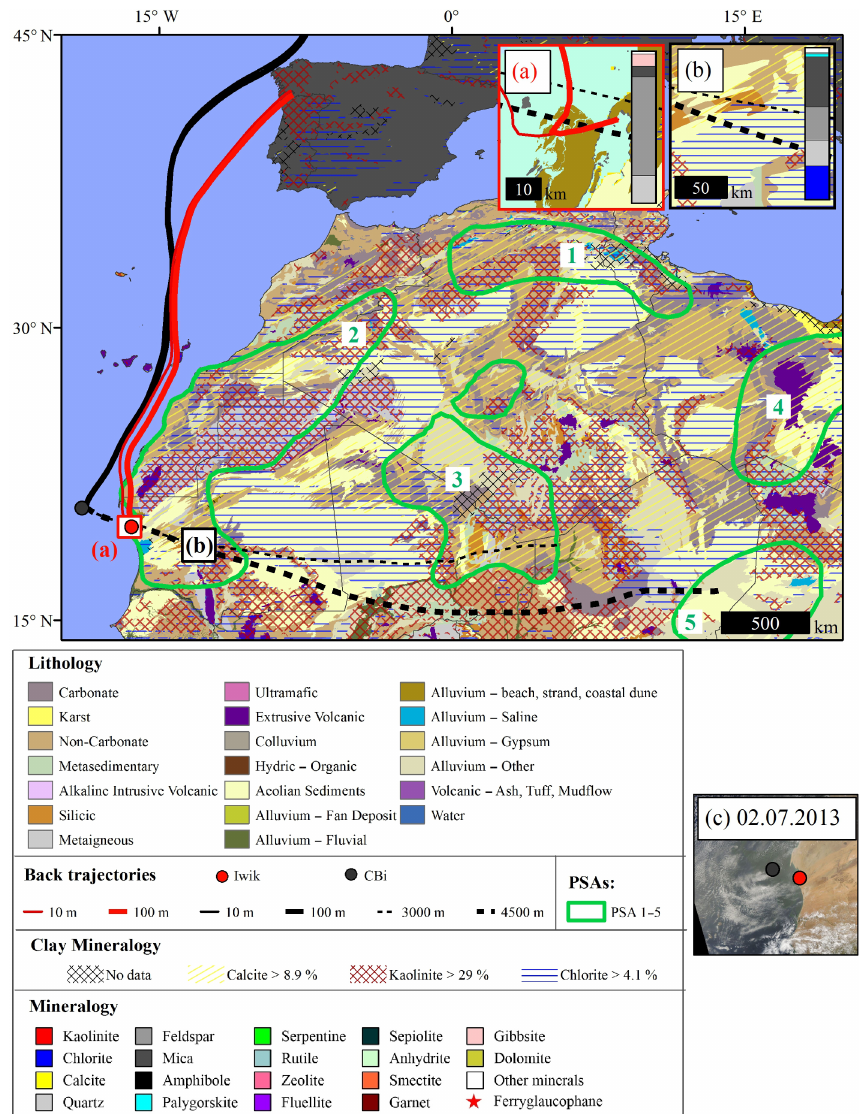
Figure 11. High- (4500m) and low-level (10m) 4-day back trajectories of a dust event ending during the sampling interval 24 June– 15 July 2013 at site Iwik and during the sampling interval 25 June–16 July 2013 at site CBi. The potential source areas and the mineralogy of the samples are given in panels (a–b) . The dust storm event is indicated in panel (c) .